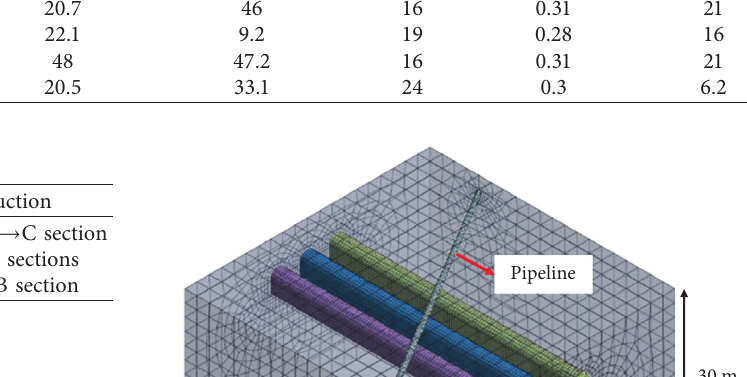
Table 3: Parameters of the pipeline.